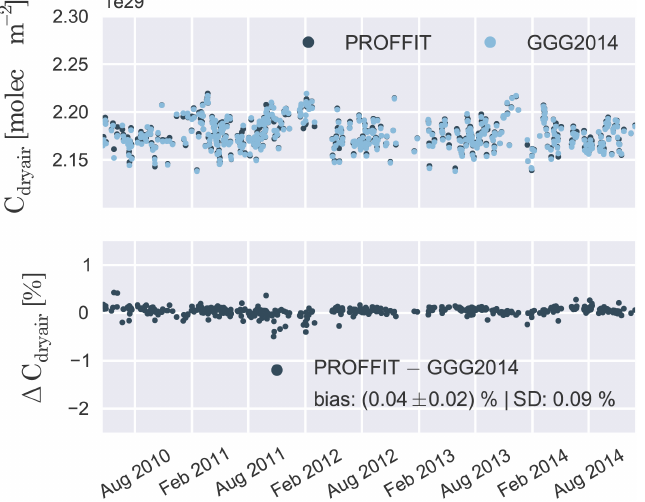
Figure A1. Upper panel: daily mean time series of C dryair retrieved from the oxygen 7885cm − 1 absorption band using the PROFFIT and GGG2014 retrieval algorithm; lower panel: relative difference time series (PROFFIT – GGG2014). The impact of the bias and standard deviation in the seasonal cycle is rather small and only slightly affects XCO from MIR and NIR retrievals.